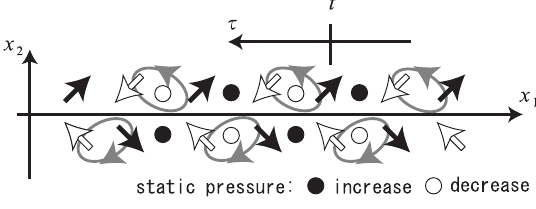
Fig. 20 Model for the vortex